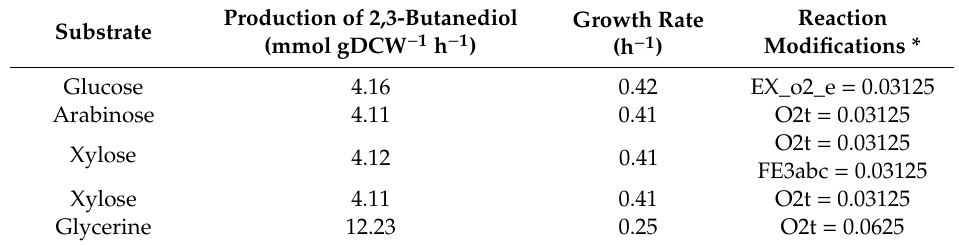
Table 5. Optimization results of Geobacillus icigianus model for 2,3-butanediol production with the pFBA algorithm.